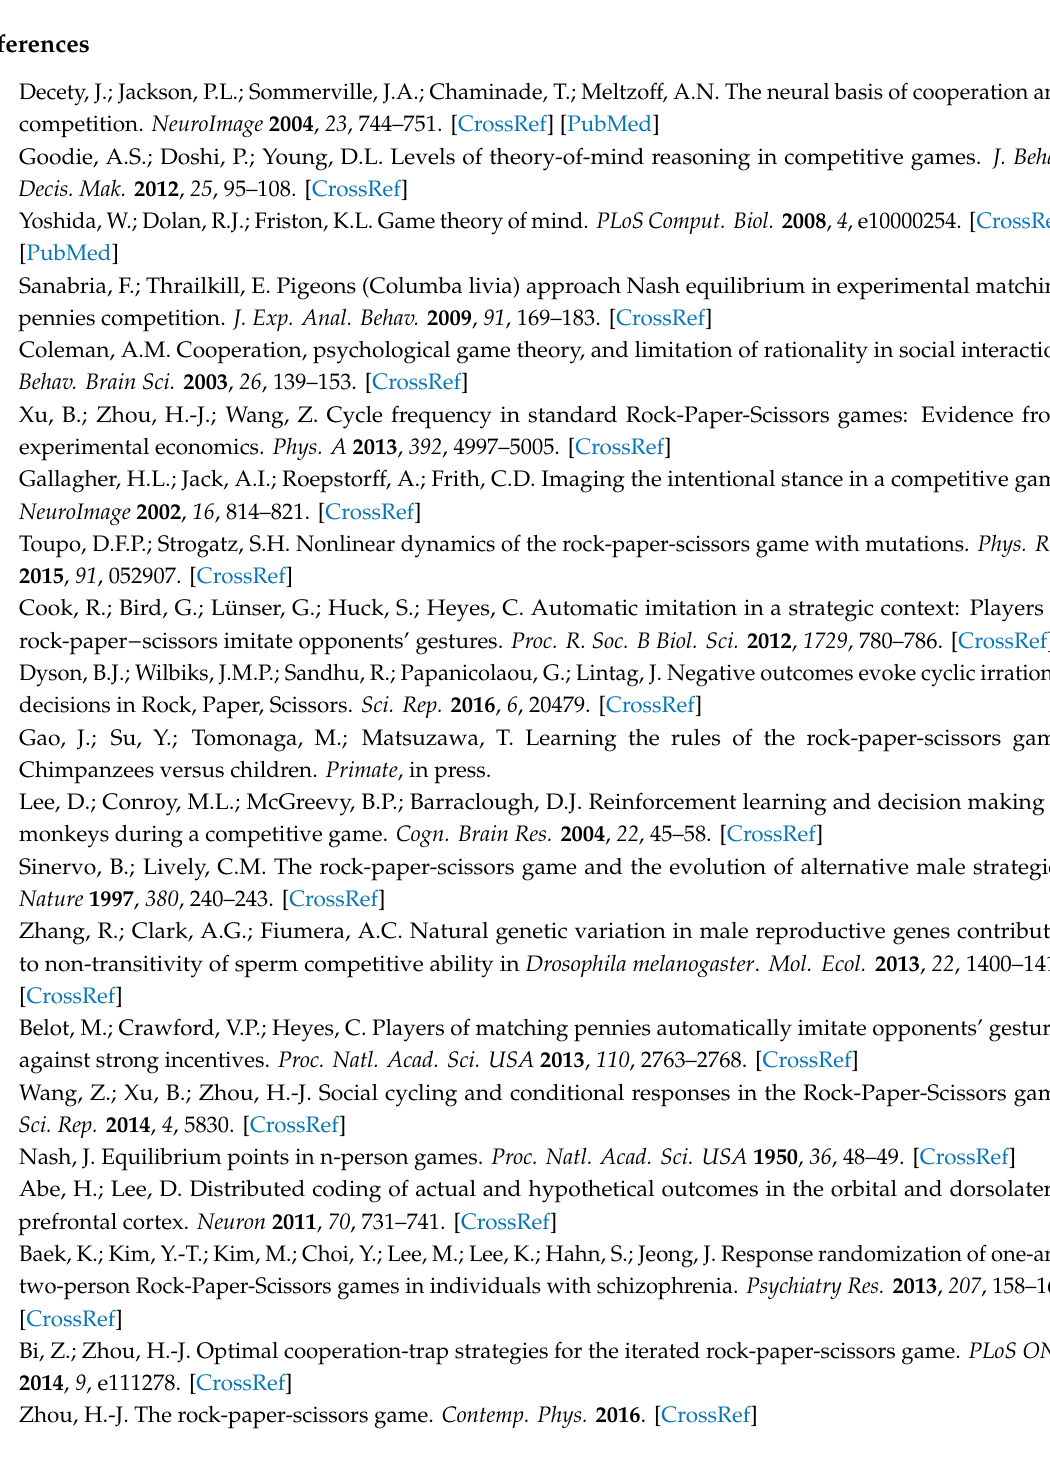
Table S1: Equivalence of deploying an other-repeat strategy (also Cournot’s Second Best Response) and an unnatural self-outcome strategy, Table S2: Equivalence of deploying an other-downgrade strategy (also Cournot’s Worse Response) and an unnatural self-outcome